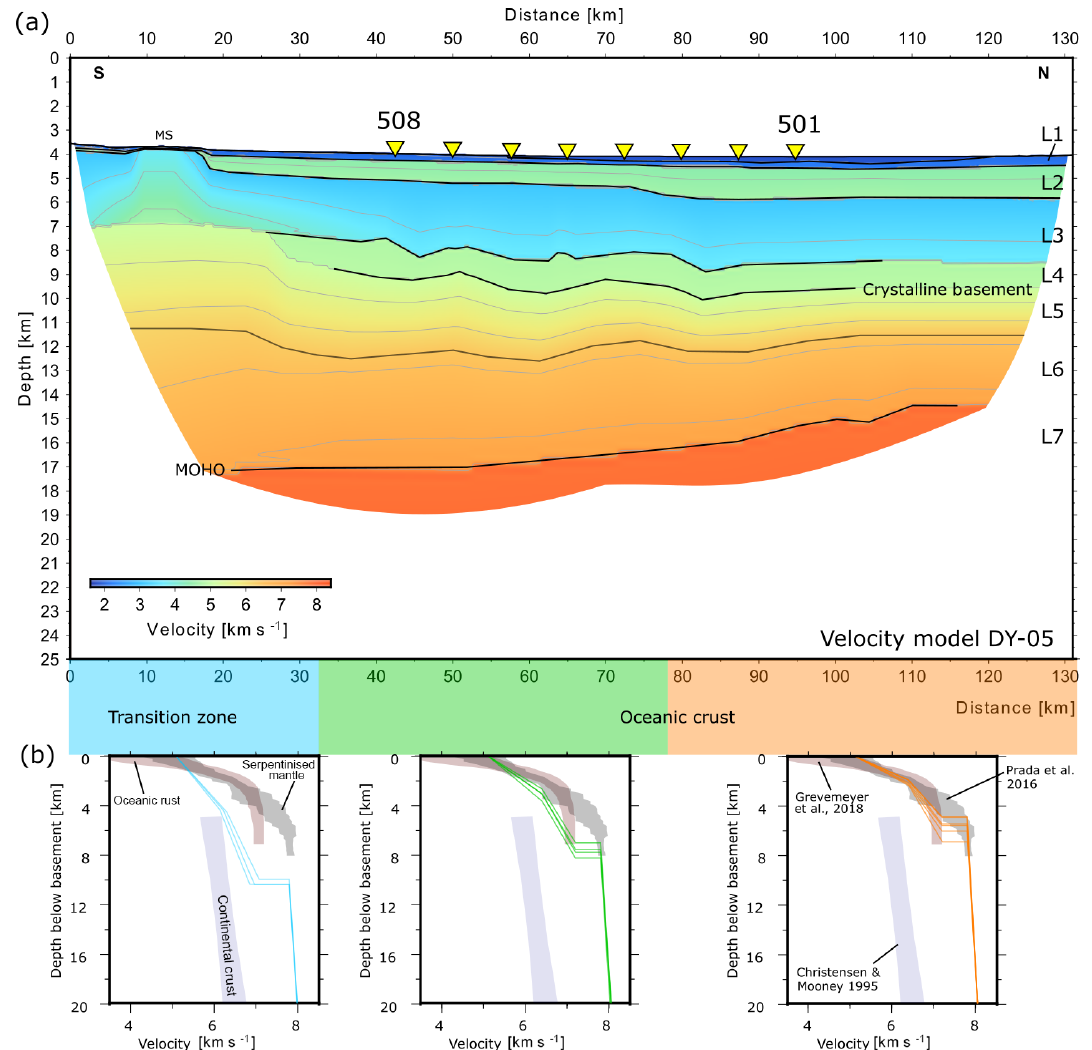
Figure 4. (a) Final velocity model for profile DY-05 obtained from forward modelling. (b) Velocity–depth functions (blue, green, and orange) starting at the basement and extracted from the final velocity model every 10km according to the coloured sections. Observed velocities are compared to oceanic crust (red grey ensemble) (Grevemeyer et al., 2018), continental crust (blue ensemble) (Christensen and Mooney, 1995), and serpentinized mantle (dark grey ensemble) found in the Tyrrhenian Sea (Prada et al., 2016). MS – Medina